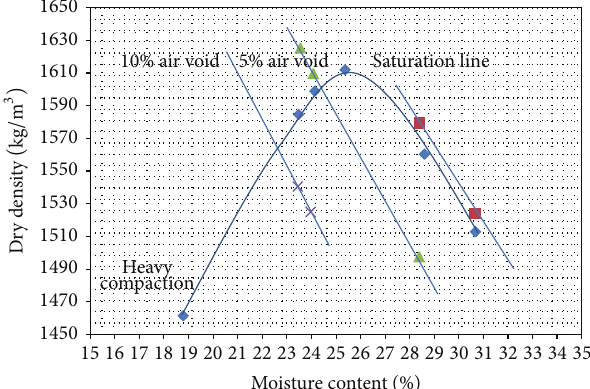
Figure 2: Compaction curve for subgrade